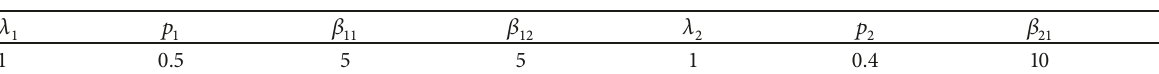
Table 3: parameter values.